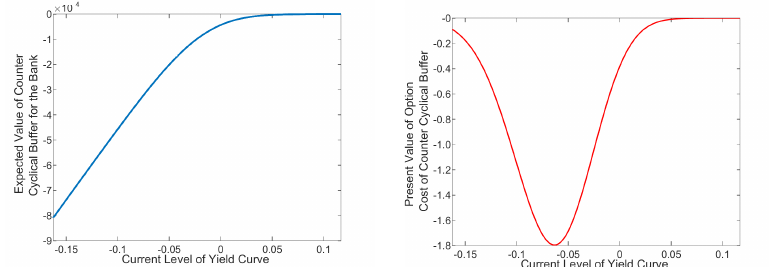
Figure 3. The Expected Payoff of Counter Cyclical Buffer